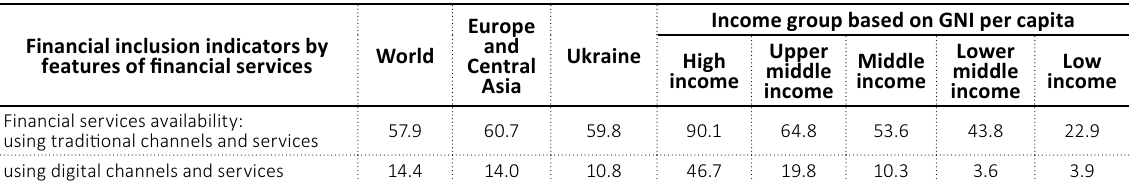
Source: Calculated by authors based on the World Bank data.